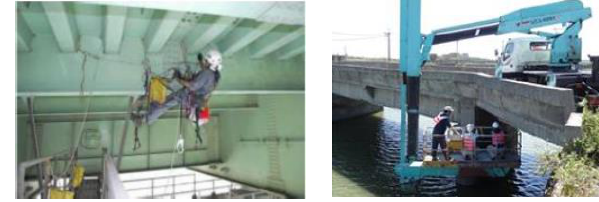
Figure 1. The traditional method for bridge inspection